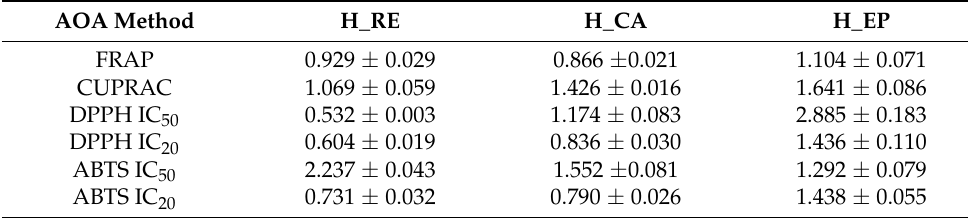
Table 3. Combination index (CI) between samples in AOA assays.